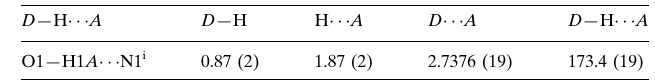
Hydrogen-bond geometry (A˚ , (cid:4)